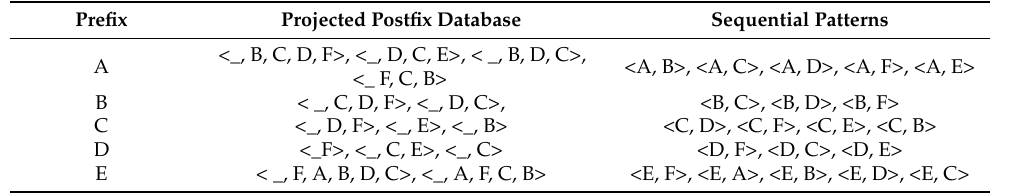
Table 7. Projected database and sequential